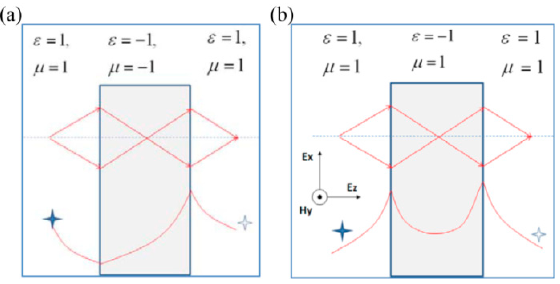
Figure 21. Imaging principle of ( a ) perfect lens and ( b ) superlens. Reproduced from [18]. Copyright © 2000, APS.